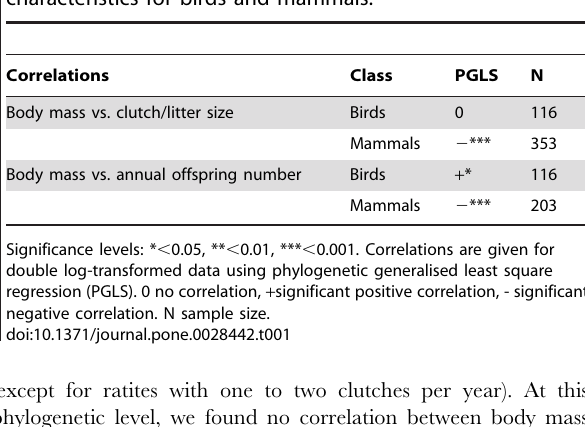
Table 1. Correlations between body mass and reproductive characteristics for birds and mammals.